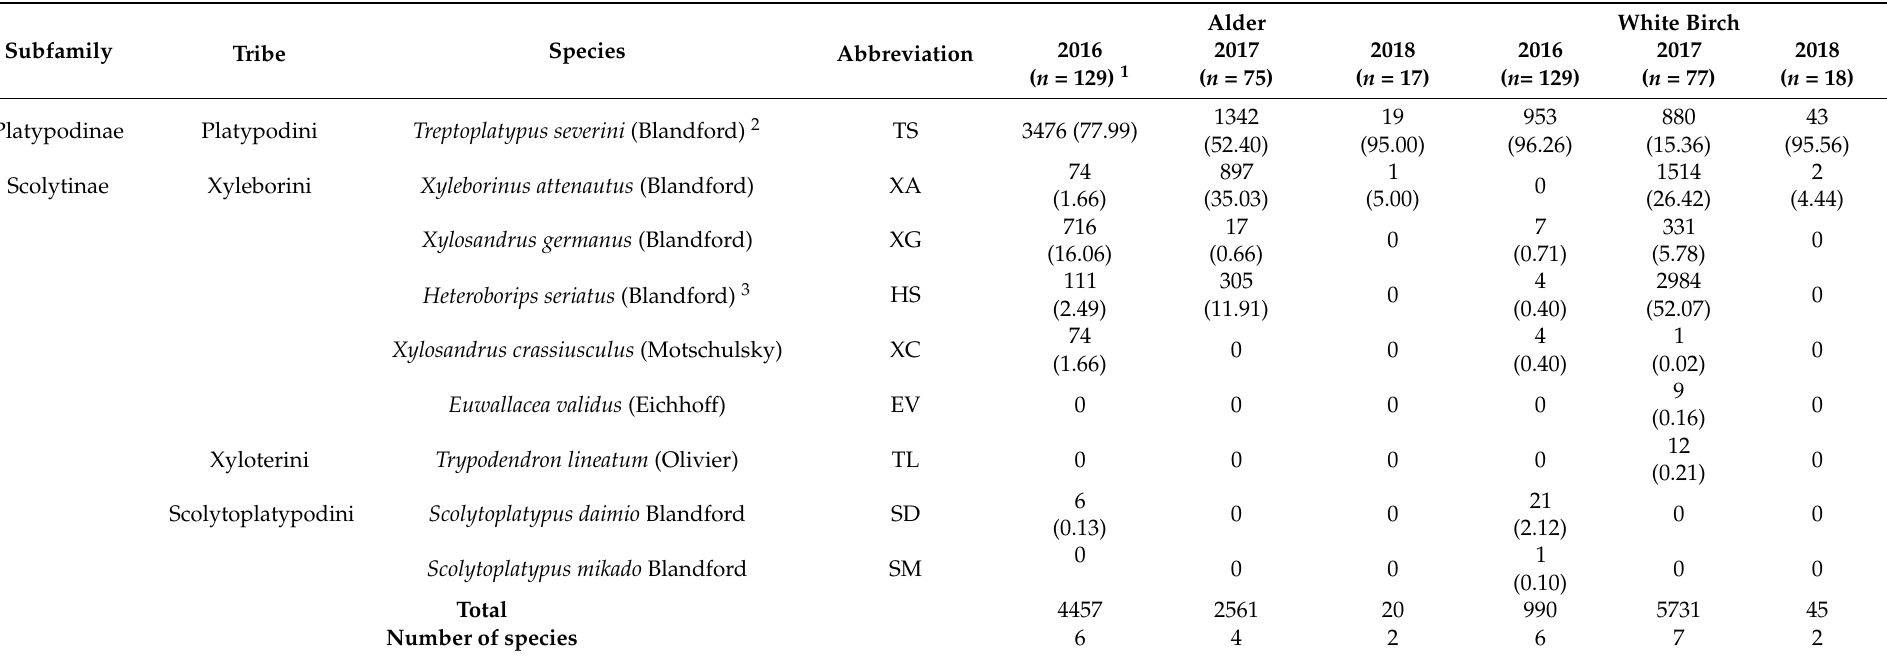
Table 1. List of ambrosia beetle species found in alder and white birch logs in each sampling year. The number of active galleries is shown for each species. The values in brackets are the proportion of each species